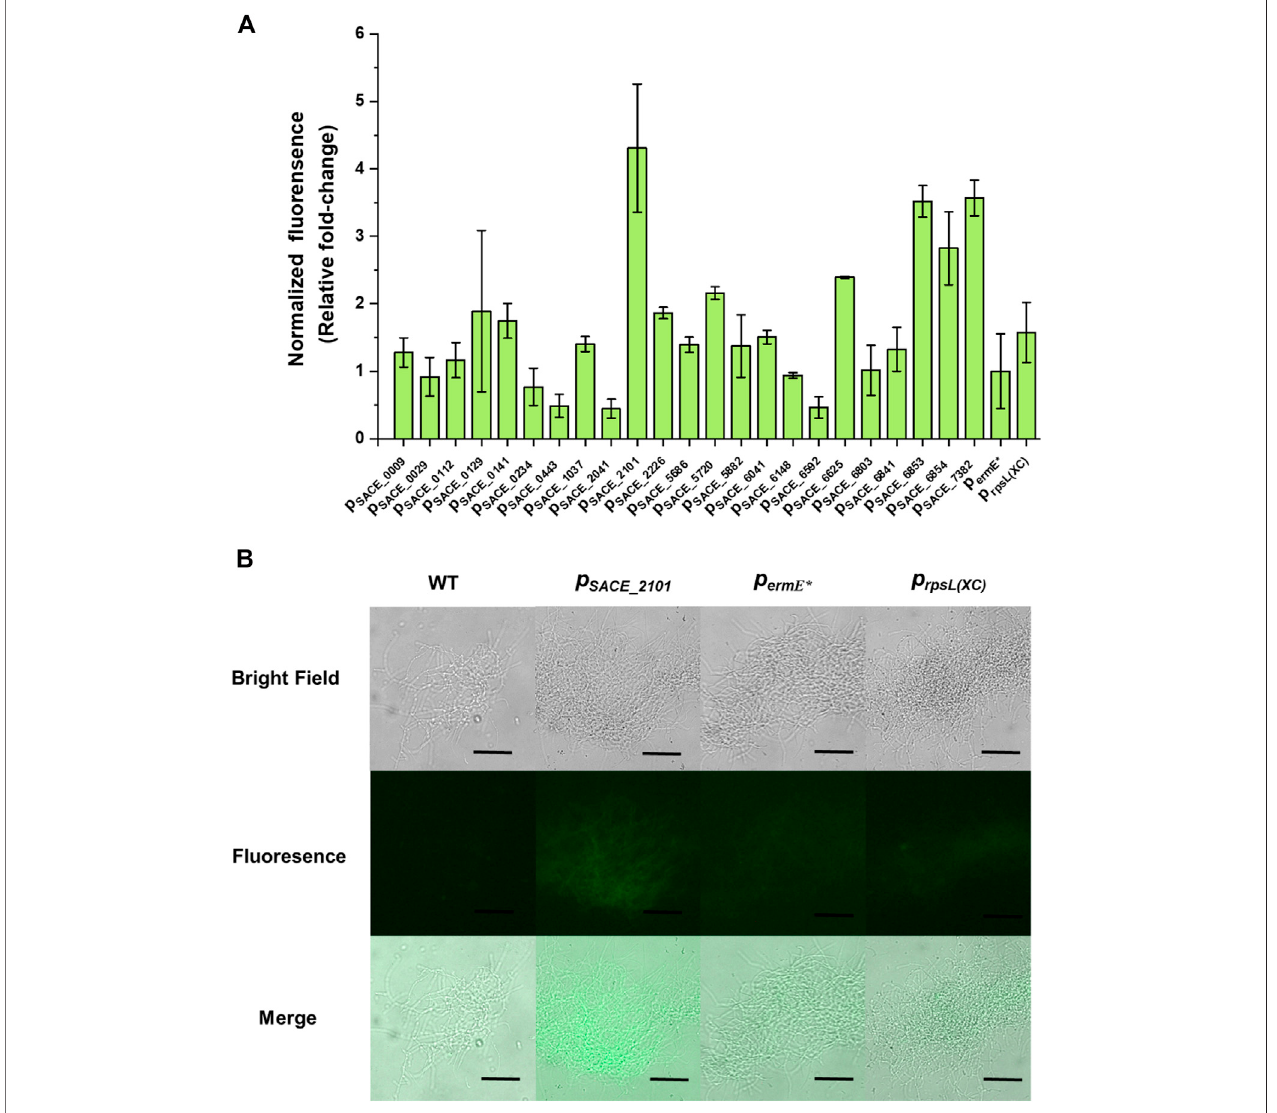
FIGURE 1 | Native promoters characterization in S. erythraea NRRL 23338. (A) Relative normalized green fl uorescence of different eGFP-expressing strains comparedtothe p ermE* -harboringstrain(fold-change).Errorbarsrepresentedthestandarddeviationofthreeparallelsamples. (B) Fluorescencemicroscopeobservation of wild-type strain S. erythraea NRRL 23338 and eGFP-expressing strains harboring promoters p SACE_2101 , p ermE* , and p rpsL(XC) . Scale bar: 50 μ m.